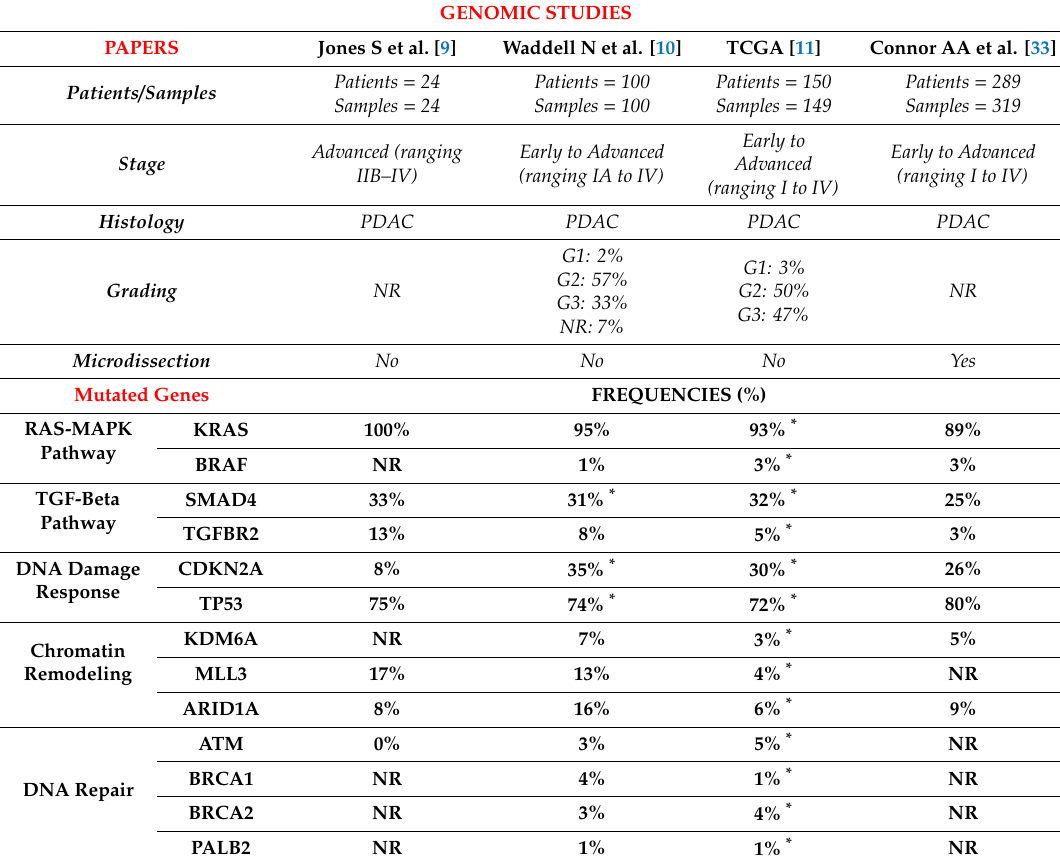
Table 2. Comprehensive list of the most frequent mutated genes (grouped by di ff erent cellular processes) in PDACs across various datasets. The table also provides clinical and pathological